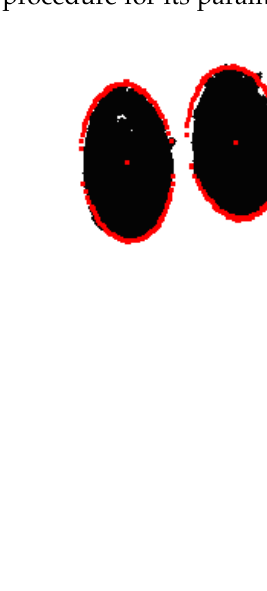
Figure 2. Algorithm of the image processing for ion tracks with inclination of 30° to the glass surface. The ion track shape on the surface is parameterized by an ellipse with the PAVICOM software. The image was simulated for ellipse with large axis of 18 microns and small ellipse axis of 11 microns corresponding to xenon tracks